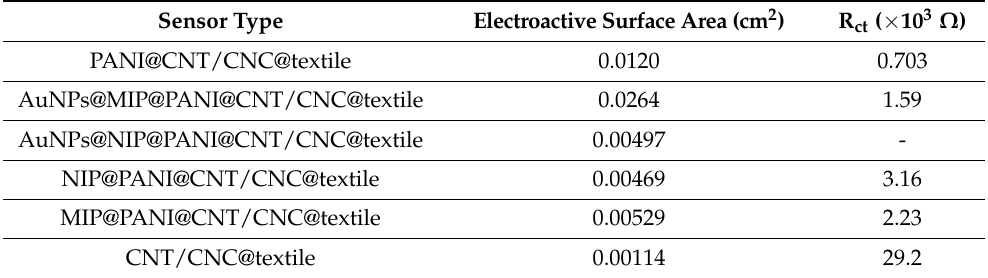
Table 1. Electroactive surface areas and electron transfer resistances (R ct ) for the various patch designs. Sensor